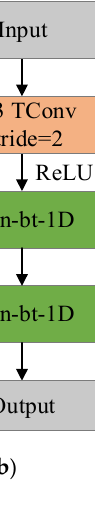
( b ) Figure 7. Lane line prediction branch. ( a ) Internal structure of lane line prediction branch. ( b ) Exter- nal structure of lane line prediction branch. 2.5. Proposed Lane Detection Model